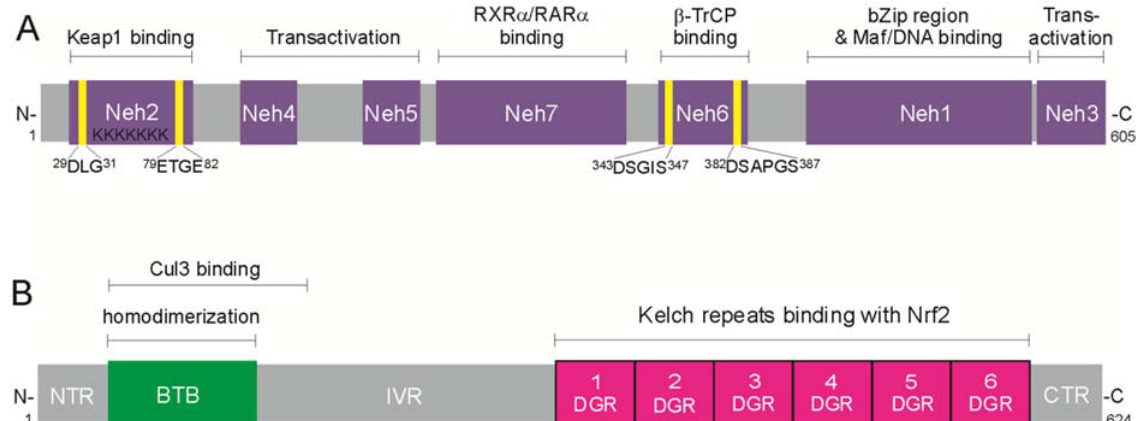
Figure 1. Multi-domain organization of Nrf2 transcription factor and Kelch-like ECH-associated protein 1 (Keap1)—the repressor of Nrf2. ( A ) A 605-amino acid Nrf2 contains seven functional domains. The N-terminal Neh2 has two 29 DLG 31 and 79 ETGE 82 motifs that bind the Keap1 homodimer, which suppresses Nrf2 and mediates its ubiquitin-dependent proteasomal degradation; the Neh4 and Neh5 recruit transcriptional co-activators, CREB-binding protein (CBP), and/or repressor-associated coactivator (RAC); the Neh7 domain mediates repression of Nrf2 by retinoid X (RXR) and retinoic acid (RAR) receptors; the Neh6 has two 343 DSGIS 347 and 382 DSAPGS 387 motifs interacting with β -transducin repeat-containing protein ( β -TrCP) and is responsible for the β -TrCP-mediated proteasomal degradation; the Neh1 contains a basic region-leucine zipper motif and is responsible for dimerization with small musculoaponeurotic fibrosarcoma (Maf), or BTB and CNC homology (Bach) proteins, the heterodimeric partners for Nrf2 to recognize the ARE sequence in target gene promoters; the C-terminal Neh3 domain is a transactivation domain that recruits chromodomain helicase DNA-binding domain protein 6 (CHD6). ( B ) Keap1 protein, the repressor of Nrf2, comprises five functional domains: the NTR domain in N-terminal region; the BTB domain, essential for homodimerization and for binding with Cul3-Rbx1 ligase complex; the intervening region (IVR), containing cysteine residues sensitive to oxidation; the double-glycine repeats (DGR)/Kelch domain, containing six Kelch-repeats, which operates as the binding sites for Nrf2; and the C-terminal region (CTR).